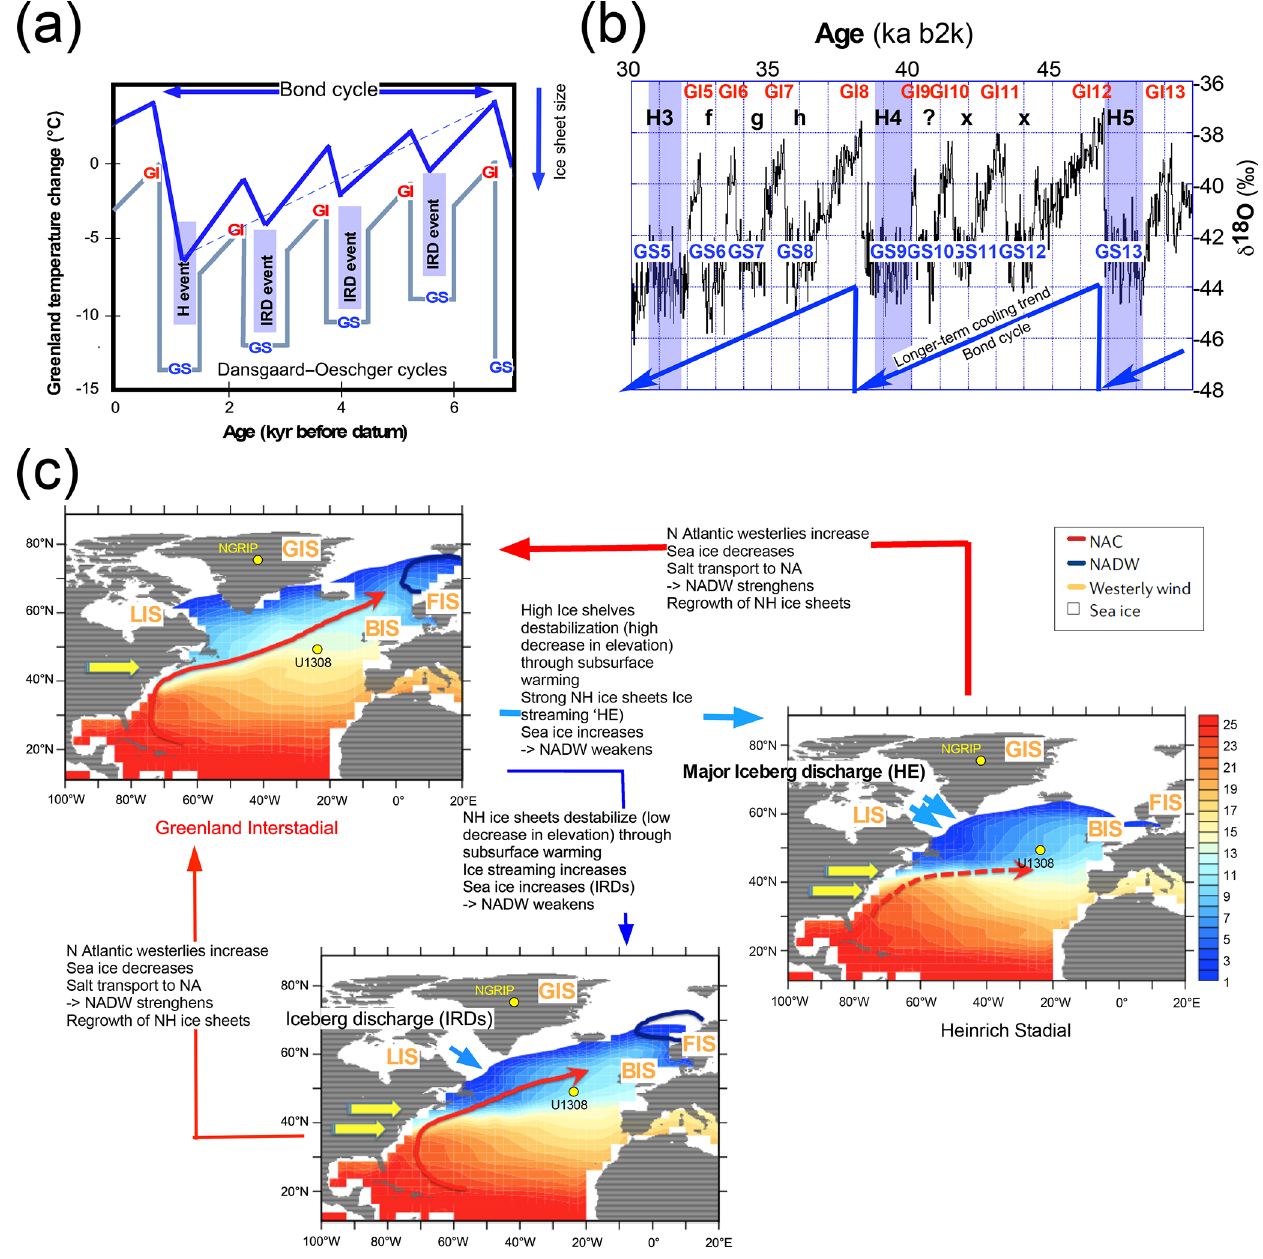
Figure 7. Schematic diagram of the proposed updated Bond cycle. (a) The amended scheme here differs from the one in Fig. 6a by adding the IRD event associated to every Greenland stadials (GS). The canonical DO are labeled here Greenland interstadials (GI). (b) The revised cycle here differs from the one in Fig. 6a by using the NGRIP δ 18 O data (Rasmussen et al., 2014) to mark the GSs and GIs. IRD events observed in contemporaneous marine records by Bond and Lotti (1995), are indicated by the letters “f” to “h”, while IRD events that were observed but not assigned a number also by Bond and Lotti (1995), are indicated by a letter “x”. HE numbers are the same as in Fig. 5. (c) Maps illustrating the climate evolution associated with the “long-term cooling trend” that corresponds to a Bond cycle in panel (a) . The last DO cycle, named a Heinrich stadial, is characterized by a massive release of icebergs. Annual mean sea surface temperature ( ◦ C) for a GI (here 47ka), a GS (here 44.4ka), and a Heinrich stadial (at 48ka), as simulated in a transient experiment of MIS3 (Menviel et al., 2014, 2021). GIS stands for Greenland ice sheet, LIS stands for Laurentide ice sheet, BIS stands for British Isles ice sheet, and FIS stands for Fennoscandian ice